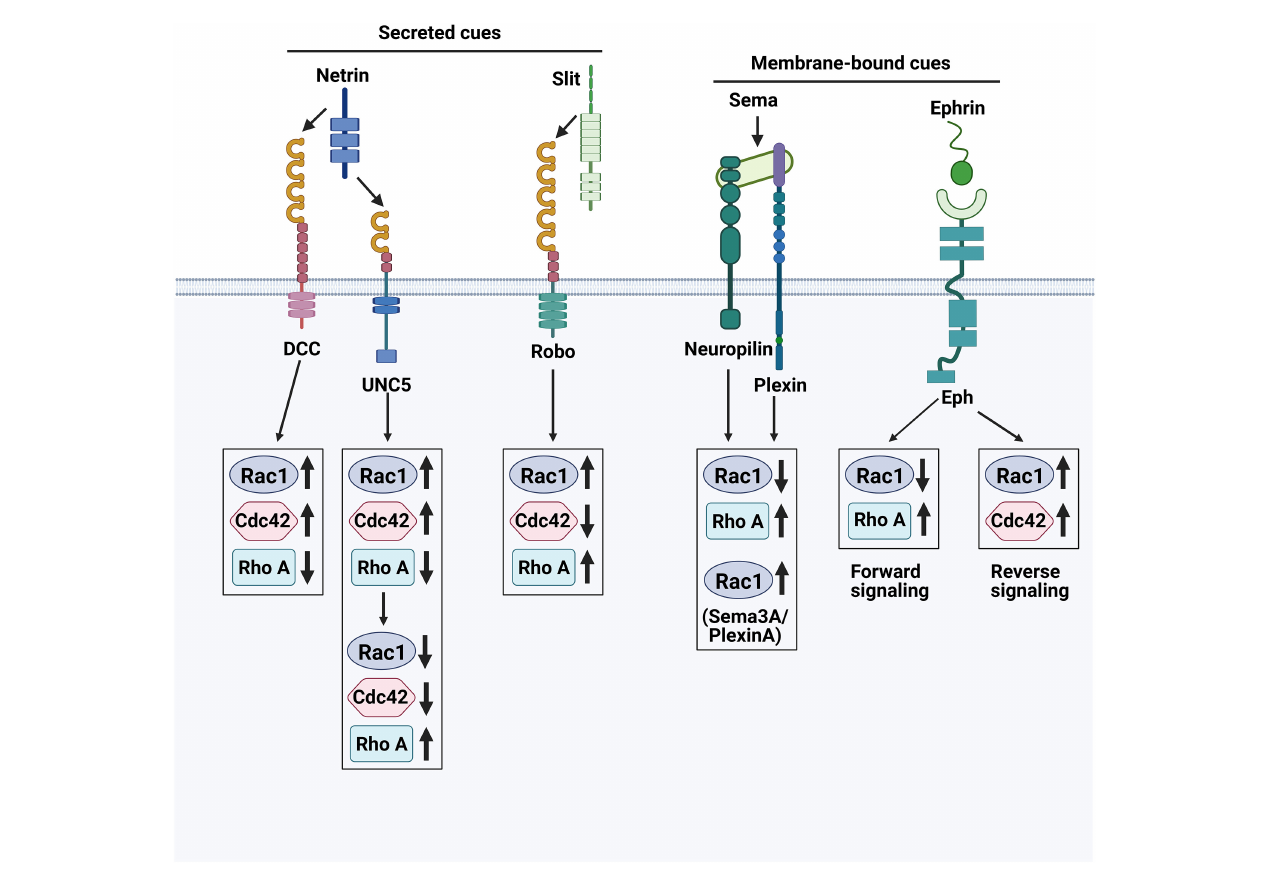
FIGURE3 Axon guidance cues and their receptors. The growth cones at the axon tip are sensitive to repulsive and attractive guidance cues in their environment. The complex integration of these repulsive and attractive signals directs axons to their proper